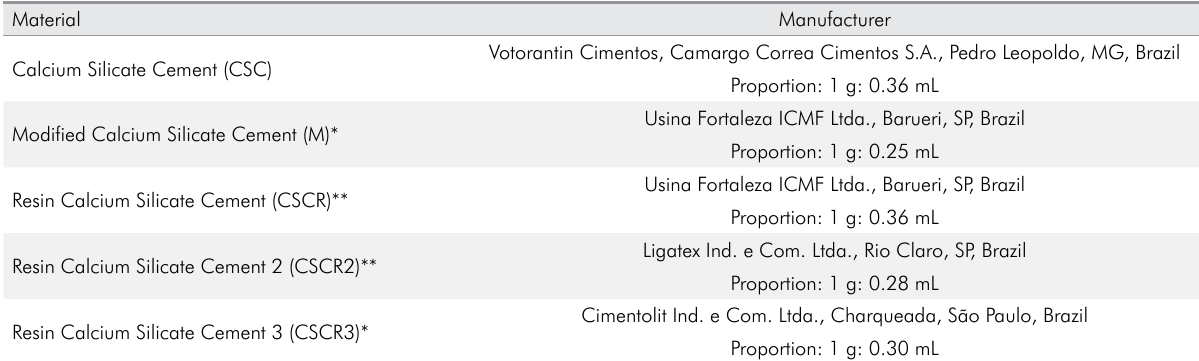
Table. Experimental materials, source and proportions used.